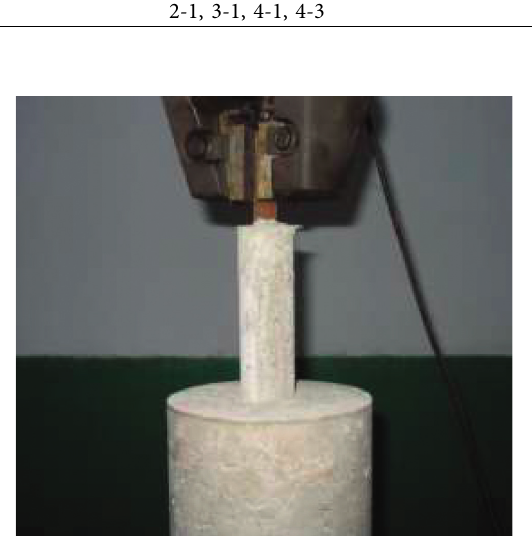
Figure 4: Debonding failure of the sample.